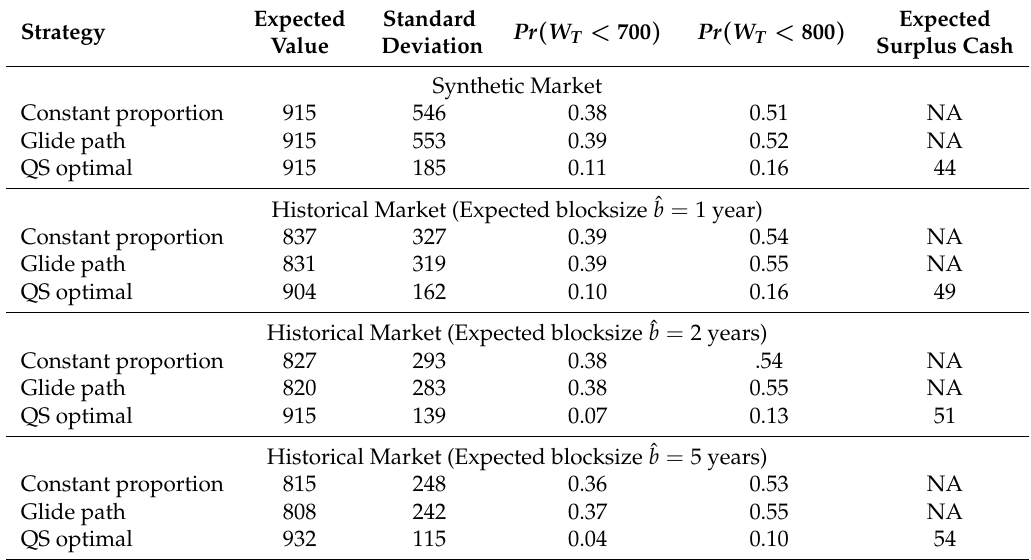
Table 9. Results when the equal-weighted equity index is used instead of the value-weighted equity index. Wealth units: thousands of dollars. Input data provided in Tables 1 and 2, except as noted. Synthetic market results computed using Monte Carlo simulations with 160,000 sample paths.